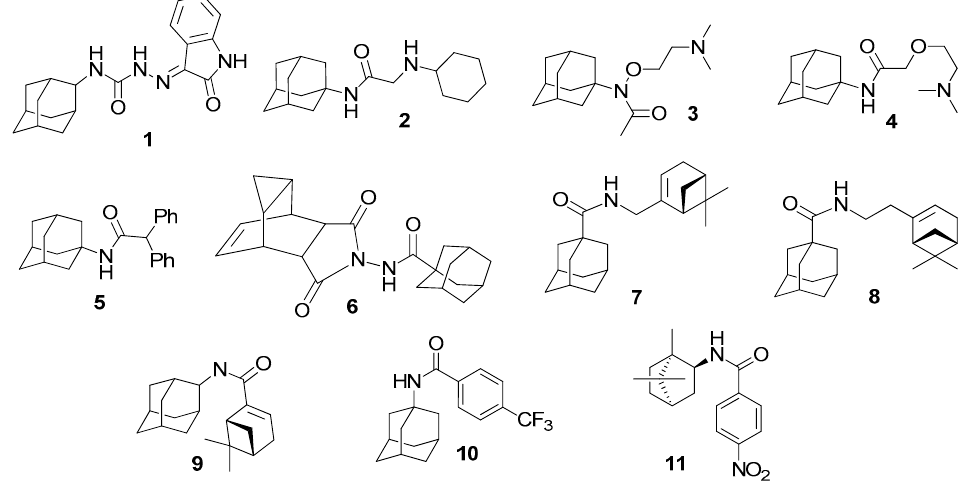
Figure 2. A number of adamantane or bicyclic monoterpene derivatives ( 1 – 11 ), active against or- thopoxviruses.